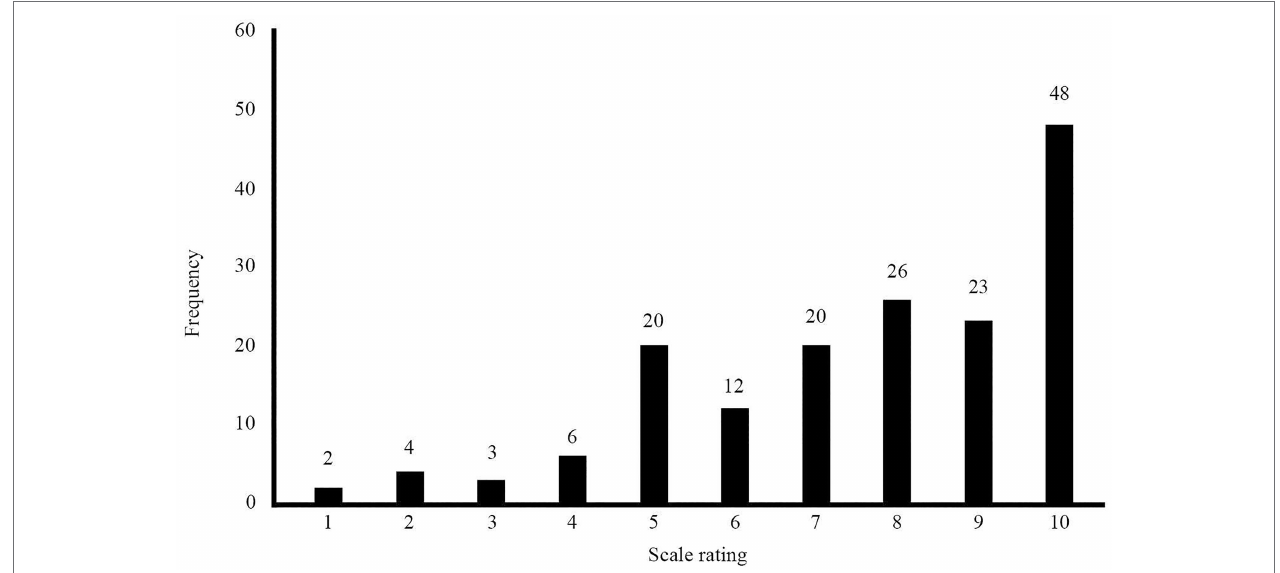
FIGURE 3 | The distribution of response scores to the post-session SWAN-OM on the scale 1–10, where 1 = strongly disagree to 10 = strongly